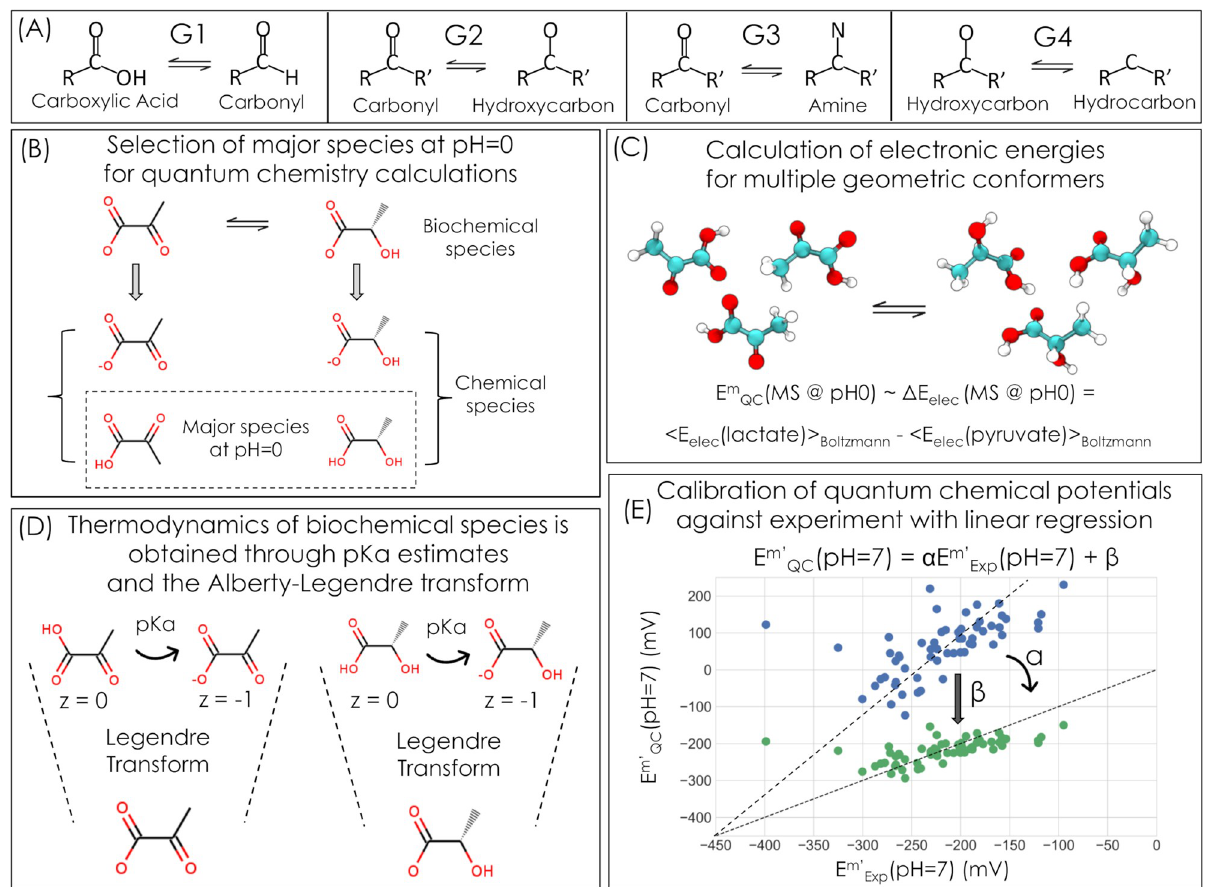
Fig 1. Our study is based on predicting biochemical standard redox potentials using a calibrated quantum chemistry strategy. (A) The four different redox reaction categories considered here are reduction of a carboxylic acid to a carbonyl—G1, reduction of a carbonyl to a hydroxycarbon— G2, or an amine—G3, and reduction of a hydroxycarbon to a hydrocarbon—G4. (B) For each redox reaction of interest, such as reduction of pyruvate to lactate, we select the most abundant protonation state at acidic pH (pH = 0) for quantum chemical simulation. (C) We estimate the chemical redox potential as the difference between Boltzmann-averaged electronic energies of geometric conformers of products and substrates. (D) In order to convert chemical redox potentials to biochemical potentials at pH = 7, we use cheminformatic pKa estimates and the Alberty-Legendre Transform (Supplementary Information). (E) Finally, we use a set of 105 experimental values obtained from the NIST Thermodynamics of Enzyme-Catalyzed Reactions database (TECRDB) [30] and a set of Gibbs formation energies compiled by Robert Alberty [31] (Supplementary Information) to calibrate redox potentials using linear